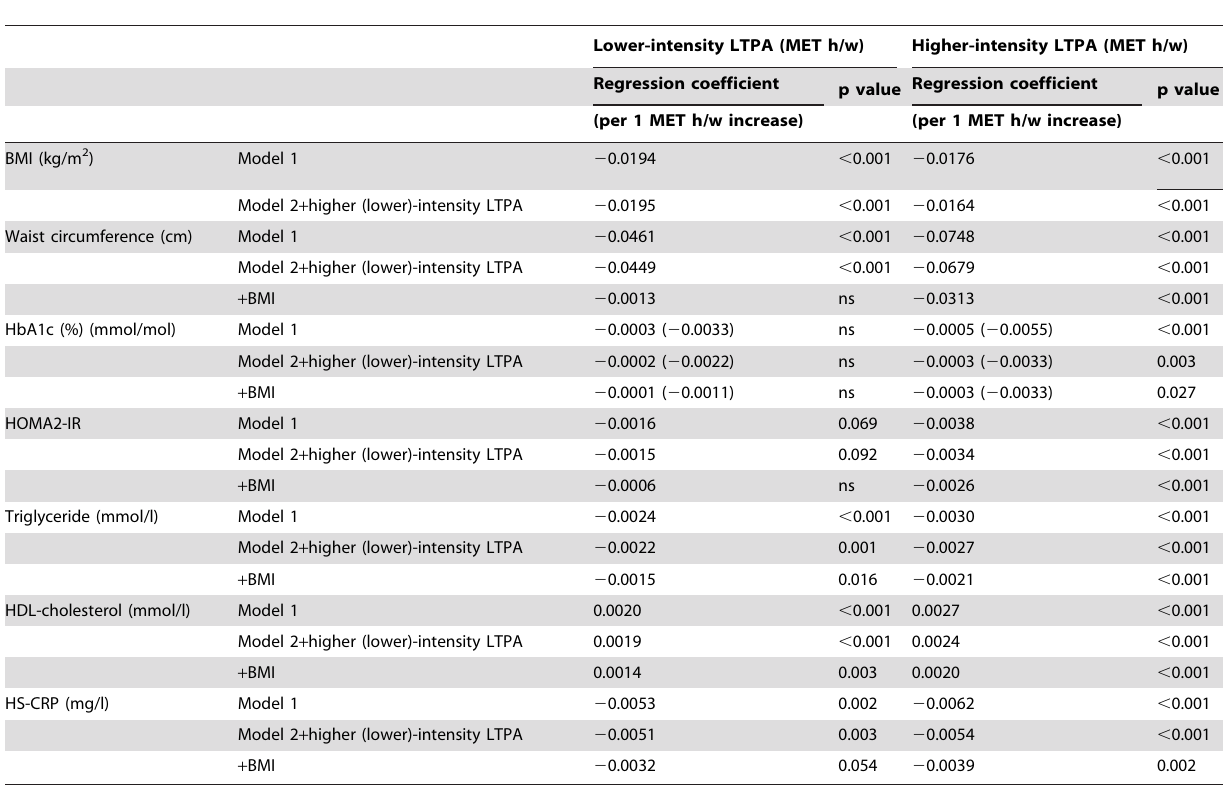
Table 3. Multiple regression analysis of lower- or higher-intensity LTPA with metabolic and inflammatory